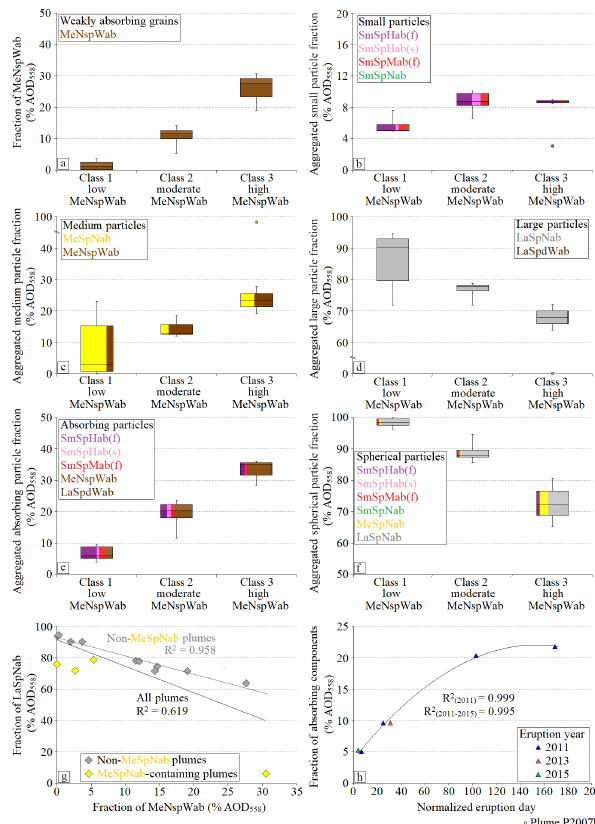
Figure 6. Box plots of the relative proportions (in quartiles; a line within the box represents the mean and a dot in Class 3 ( b – d ) represents the outlying results of P2007b ) of (a) medium, non- spherical, weakly absorbing particles (MeSpNab) used to define the three plume classes; (b) small particles (including SmNspNab, Sm- SpHab(f), SmSpHab(s), SmSpMab(f)); (c) medium particles (in- cluding MeSpNab and MeNspWab); (d) large particles (including LaSpNab and LaSpdWab); (e) absorptivity of plumes; (f) relative sphericity, all stratified by class type; (g) fraction of large spheri- cal particles (LaSpNab) relative to medium grains (MeNspWab) for each Karymsky plume, including correlation statistics for all sam- ples and non-MeSpWab containing plumes; and (h) fraction of ab- sorbing components relative to normalized eruption day for plumes observed from 2011 to 2015. Note: scales differ between compo- nents. The color fraction of each box plot (as defined in Table 2 and earlier figures) indicates the relative proportion of each contributing aerosol